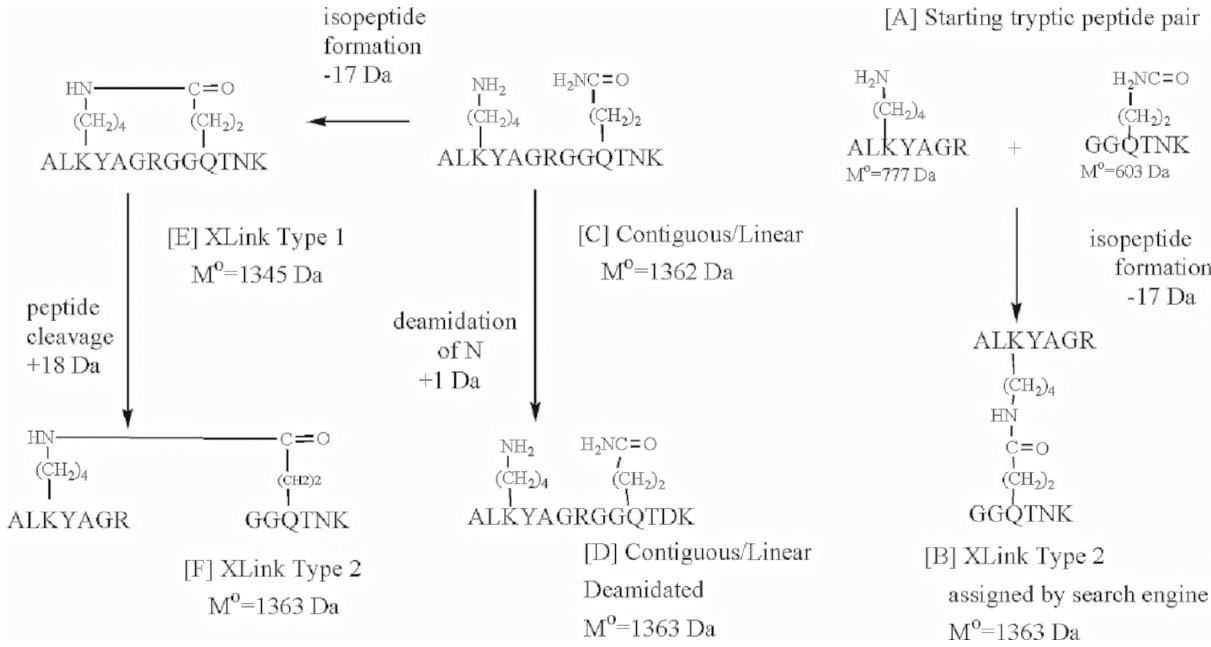
Fig 9. A scheme for possible structures that could be associated with an isopeptide crosslink in a linear peptide